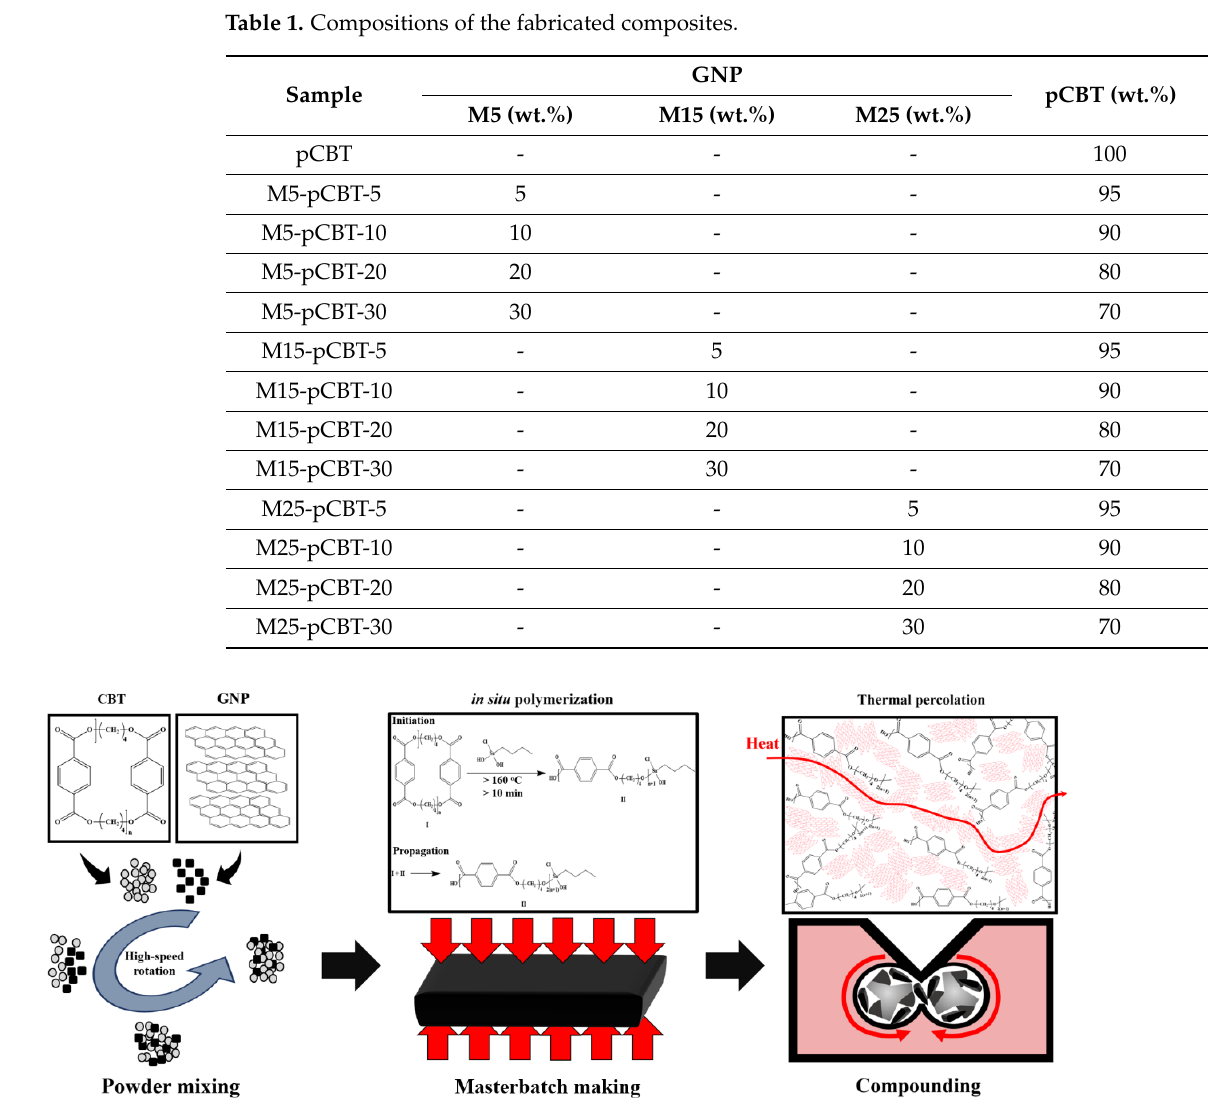
Table 1. Compositions of the fabricated composites.